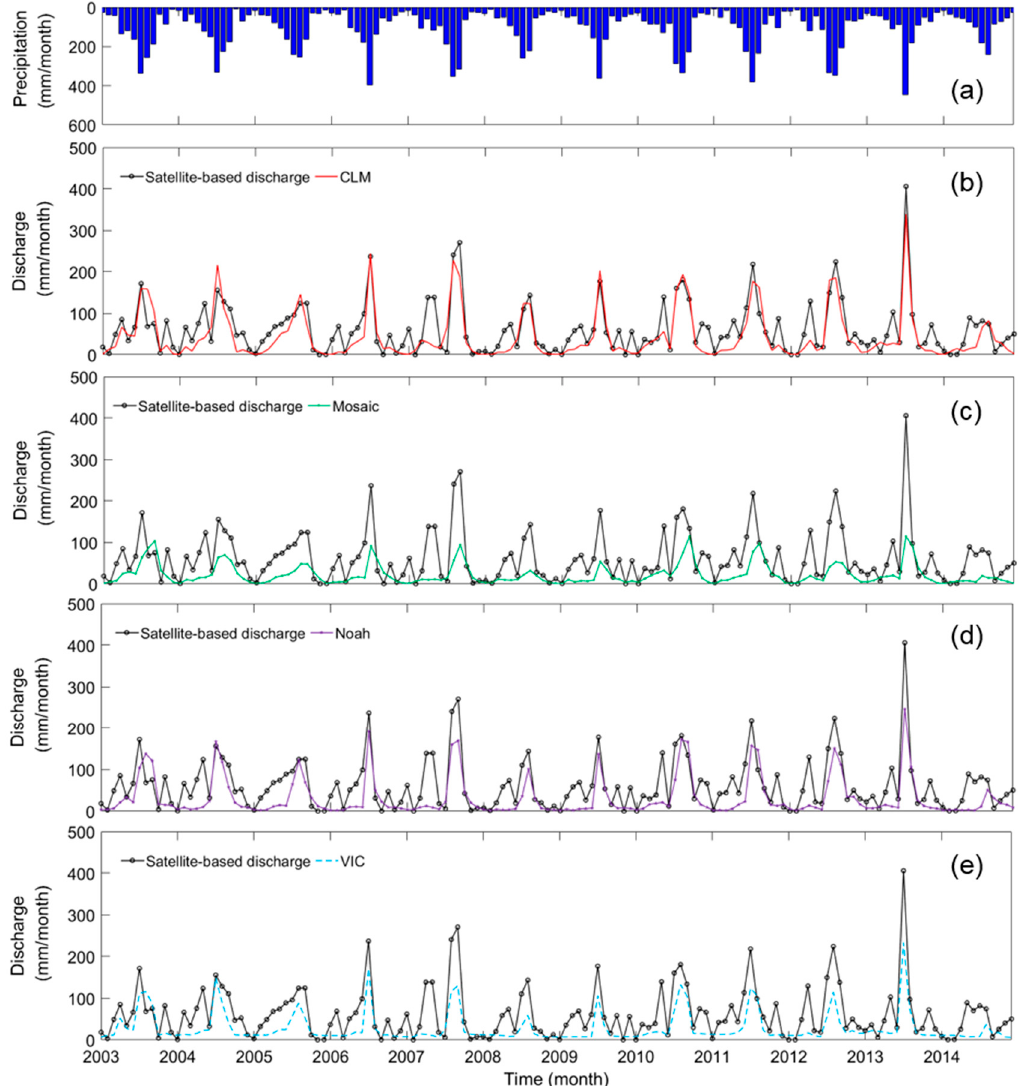
Figure 9. Time series of precipitation; ( a ) the satellite-based discharge and land surface model (LSM)-based discharge; ( b ) common land model (CLM); ( c ) Mosaic; ( d ) Noah; ( e ) variable infiltration capacity (VIC) over the Korean Peninsula.